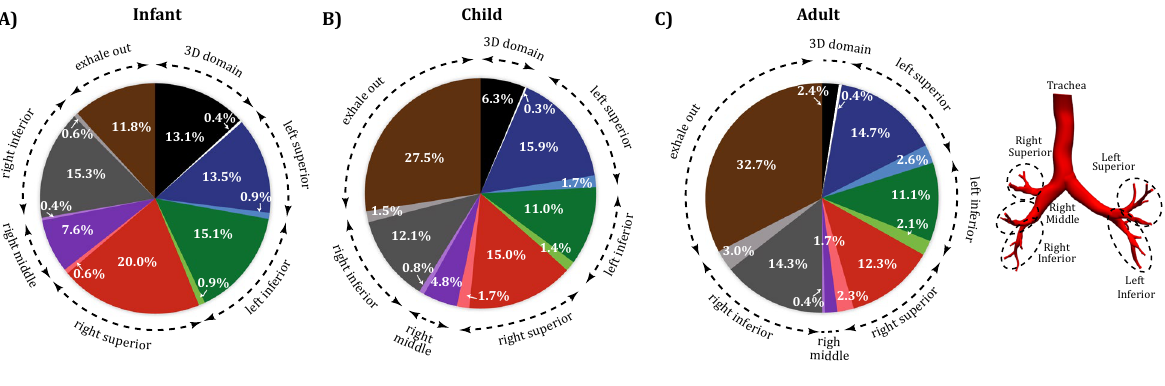
Figure 4. Whole lung deposition percentages (for 3 µ m diameter particles) for the infant ( A ), child ( B ), and adult ( C ) airways. The 3D geometry as well as the five lobes are highlighted, with expiration represented with the lighter shades. The percentage of particles exhaled out of the lungs are also shown for each of the age